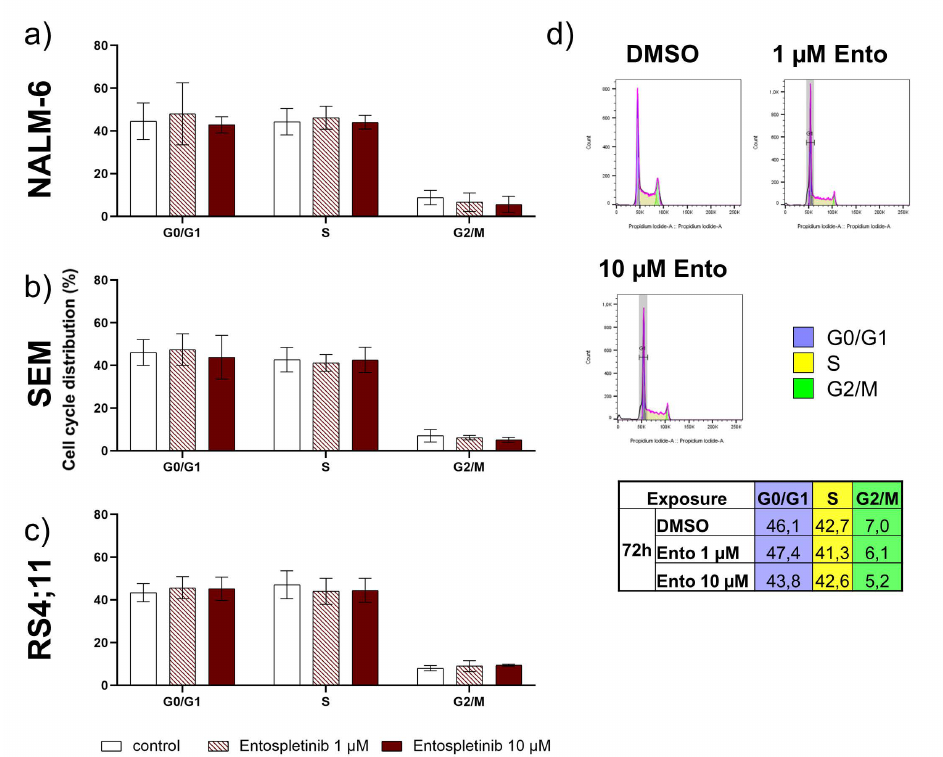
Figure 5. Flow cytometric cell-cycle analysis of the B-ALL cells after entospletinib exposure. B-ALL cell lines NALM-6, SEM and RS4;11 were exposed to 1 µ M or 10 µ M entospletinib for 72 h. ( a ) Mean cell-cycle distribution of NALM-6, ( b ) SEM and ( c ) RS4,11. ( d ) Representative histograms of the cell-cycle distribution of the SEM cells exposed to entospletinib or the vehicle, calculated by FlowJo Software, and the mean calculation of the cell-cycle phases. Data are presented as the mean ± SD. Statistical significance was calculated by one-way ANOVA followed by Dunnett’s test as a post-hoc ( n ≥